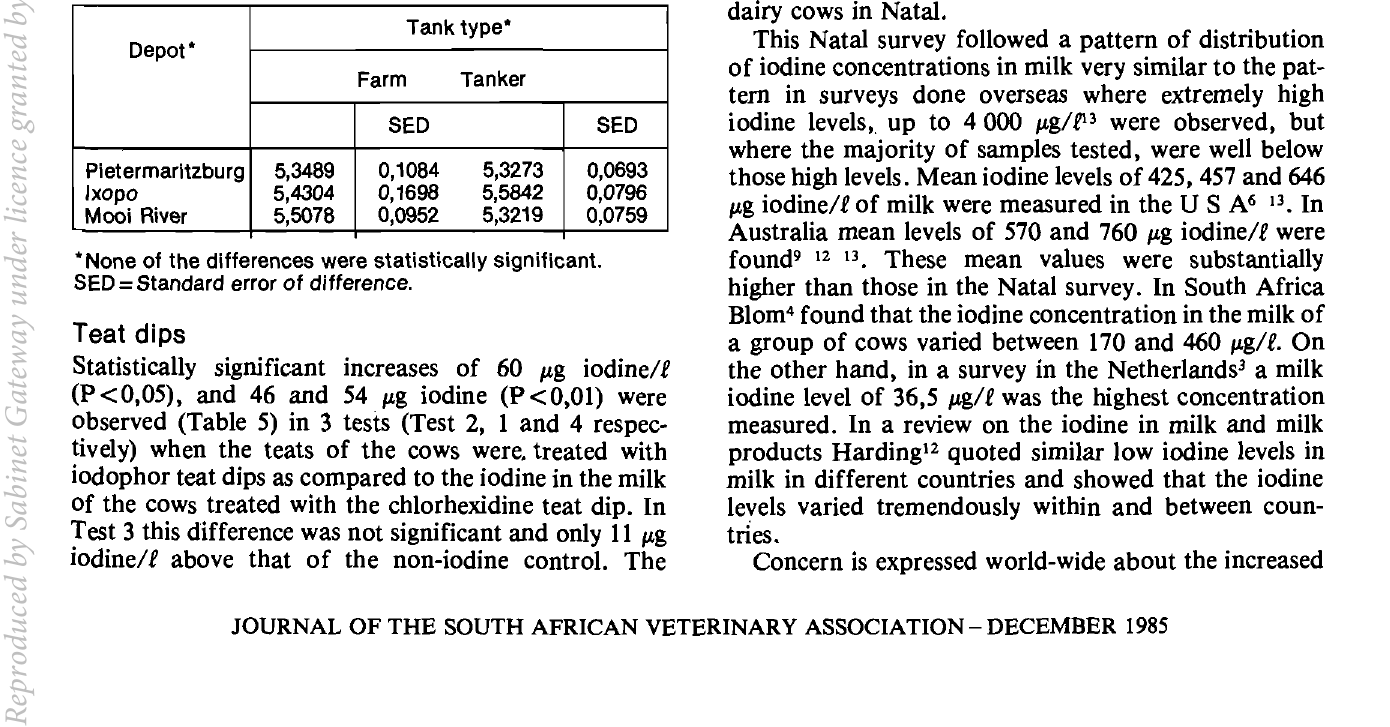
Table 4: Logarithmiq transformed medians to compare iodine concentrations (/Lg/f) between milk depots and type of container of the milk